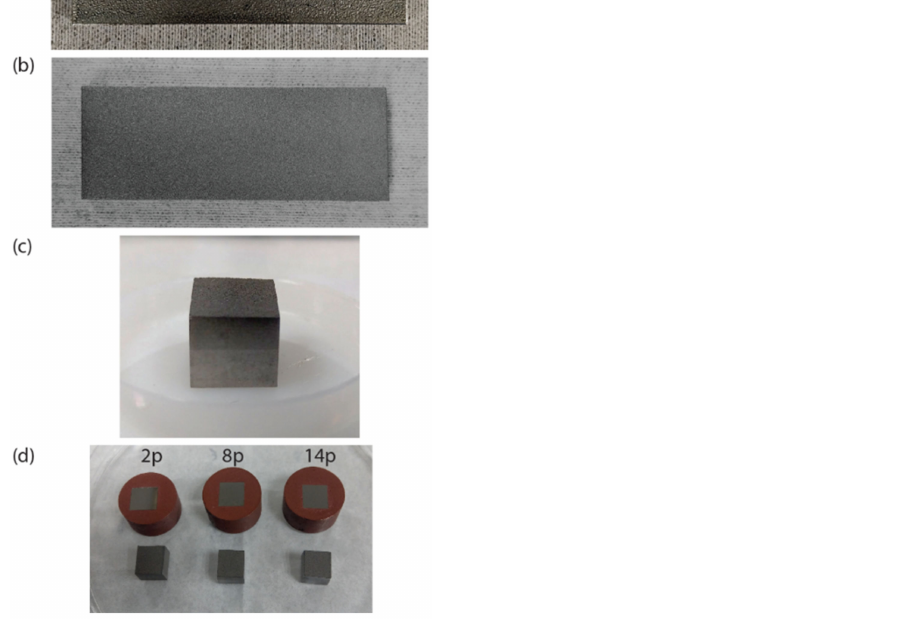
Figure 2. Preparation of cold-sprayed Ti. ( a ) The Ti substrate after grit blasting and purging with pressur- ized air; ( b ) Ti substrate type of 2p after cold spray deposition; ( c ) A 1 cm 3 Ti cube; ( d ) Mounted